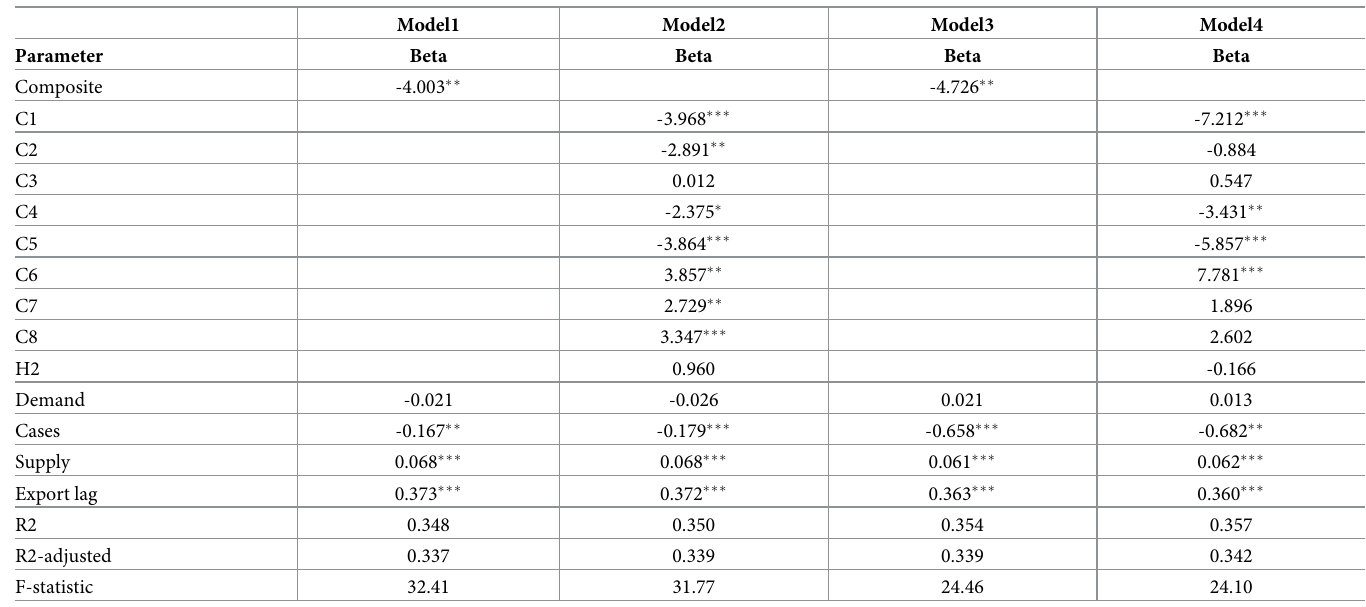
Table 3. The results of the various regression models.